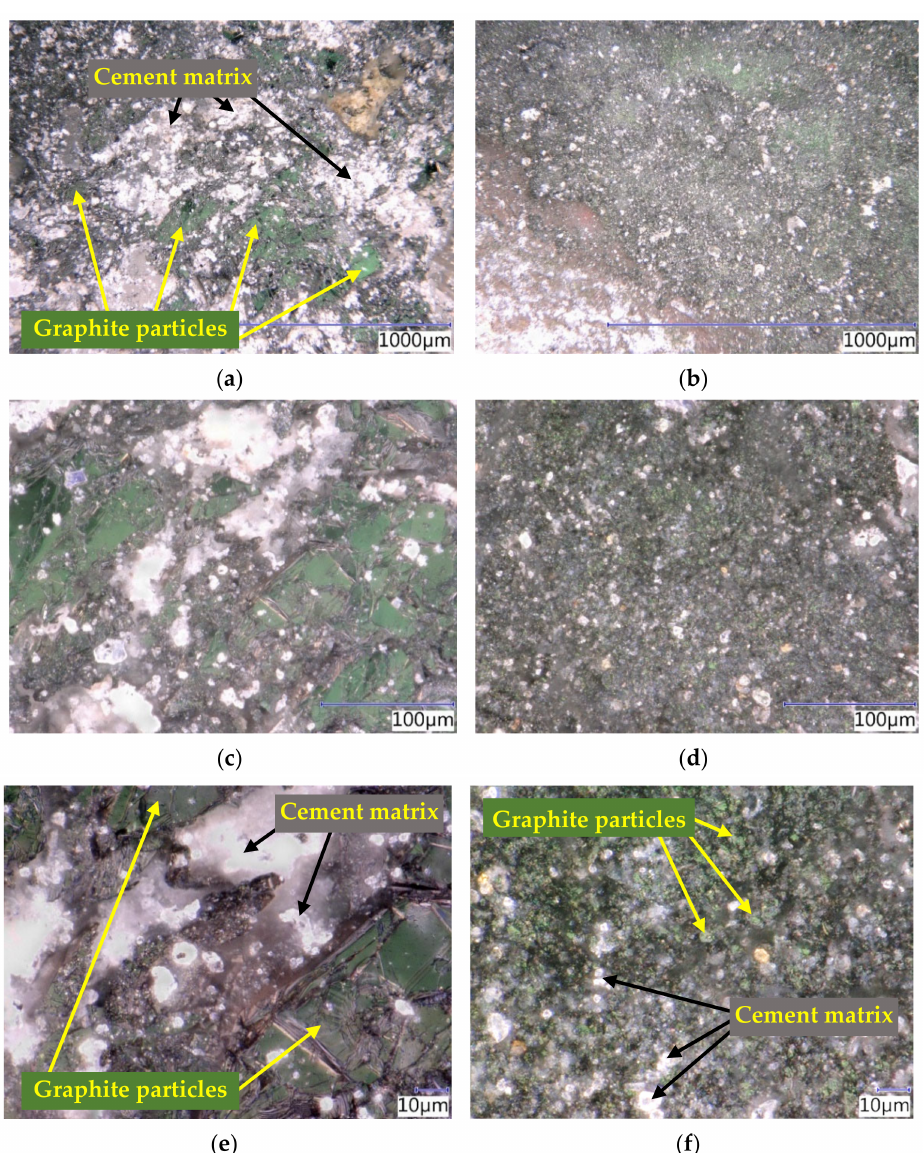
Figure 17. Images from the optical microscope: cement composites with graphite filler in cut speci- mens (Supragraphite C300—( a , c , e ); Condufit C4—( b , d , f )) at 250 × magnification ( a , b ), 1000 × magni- fication ( c , d ), 2500 × magnification ( e , f